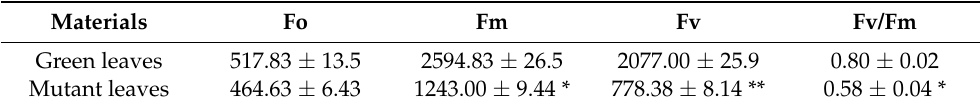
Table 2. Chlorophyll fluorescence kinetic parameters of green and mutant leaves. Materials Fo Fm Green